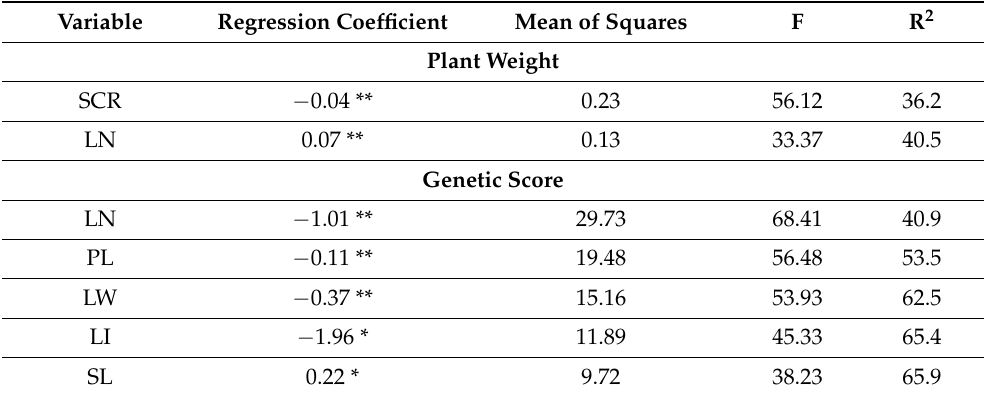
Table 7. Forward regression in salinity stress conditions for when plant weight and genetic code were considered as dependent variables and the other attributes as independent variables.